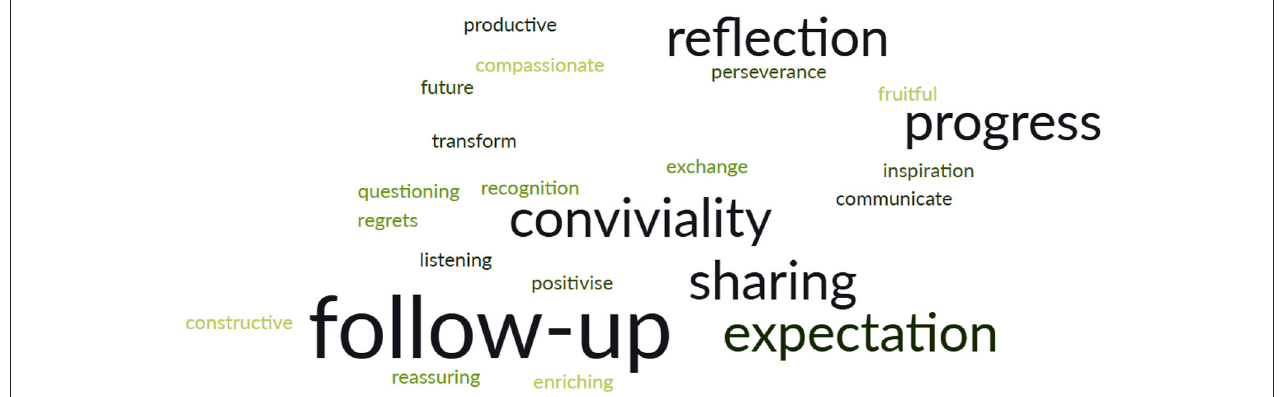
FIGURE 6 | Word cloud based on one-word evaluation of the day across the three